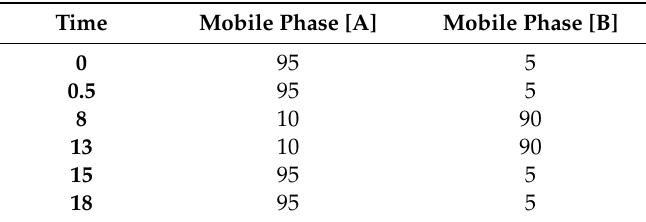
Gradient elution program for the determination of pesticide residues in rice by high-performance liquid chromatography-tandem mass spectrometry (HPLC-MS / MS). Time Mobile Phase [A] Mobile Phase [B] 0